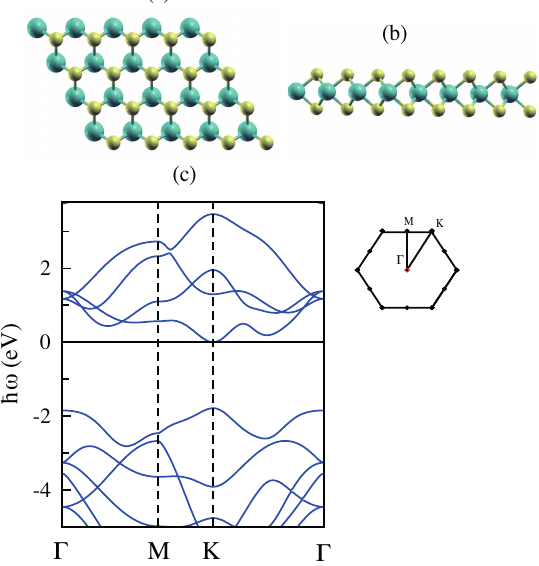
Figure 8. ( a , b ) Top and side view of the atomic structure of molybdenum disulfide (MoS 2 ). ( c ) The band structure of MoS 2 along the high symmetry Γ − M − K − Γ directions and the associated Brillouin zone. The Fermi level is set at 0 eV. The blue balls are molybdenum atoms, and the yellow ones are sulfur